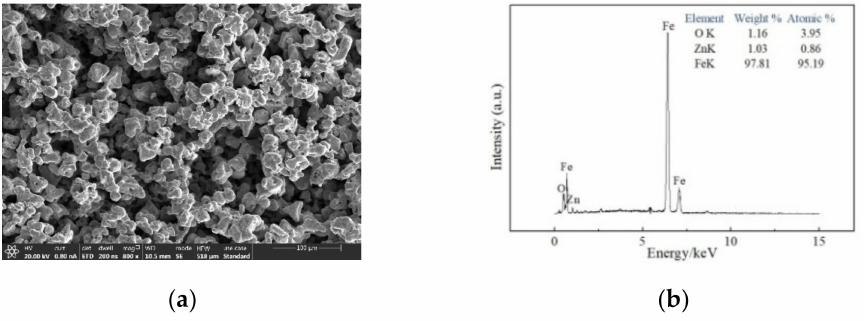
Figure 10. ( a ) SEM and ( b ) EDS diagrams of products at 1.8 V electrolysis voltage ( T = 800 ◦ C, t = 8 h).